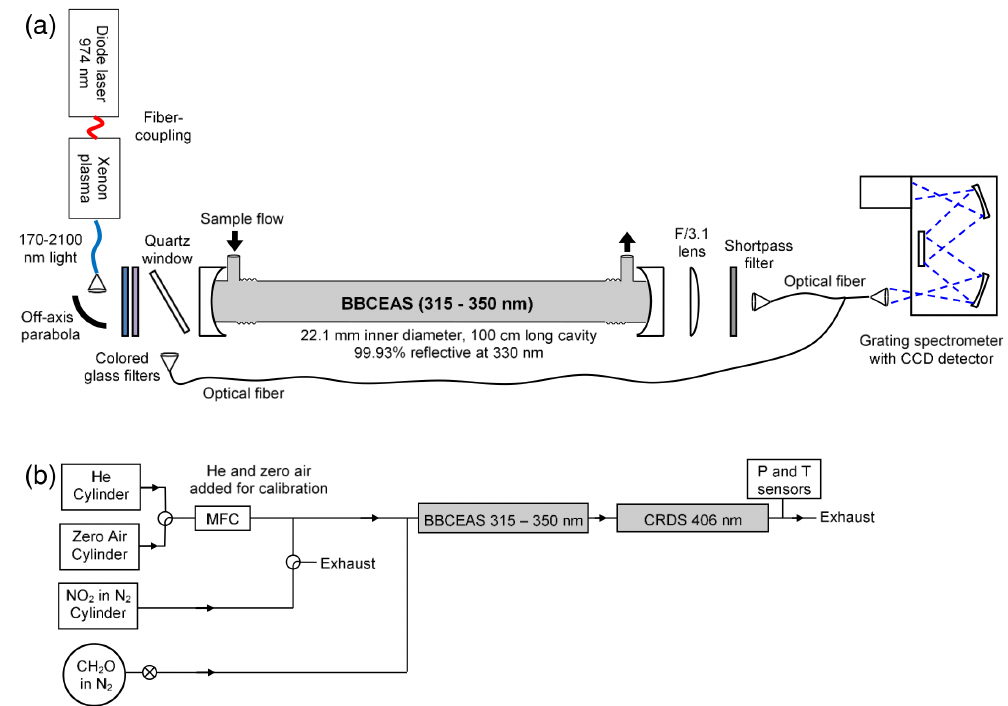
Figure 1. (a) Schematic of the broadband cavity-enhanced absorption spectrometer, showing the laser-driven arc lamp, collimating optics, cavity, and spectrometer. (b) Block diagram showing the flow system to introduce He, zero air, CH 2 O, and NO 2 to the two